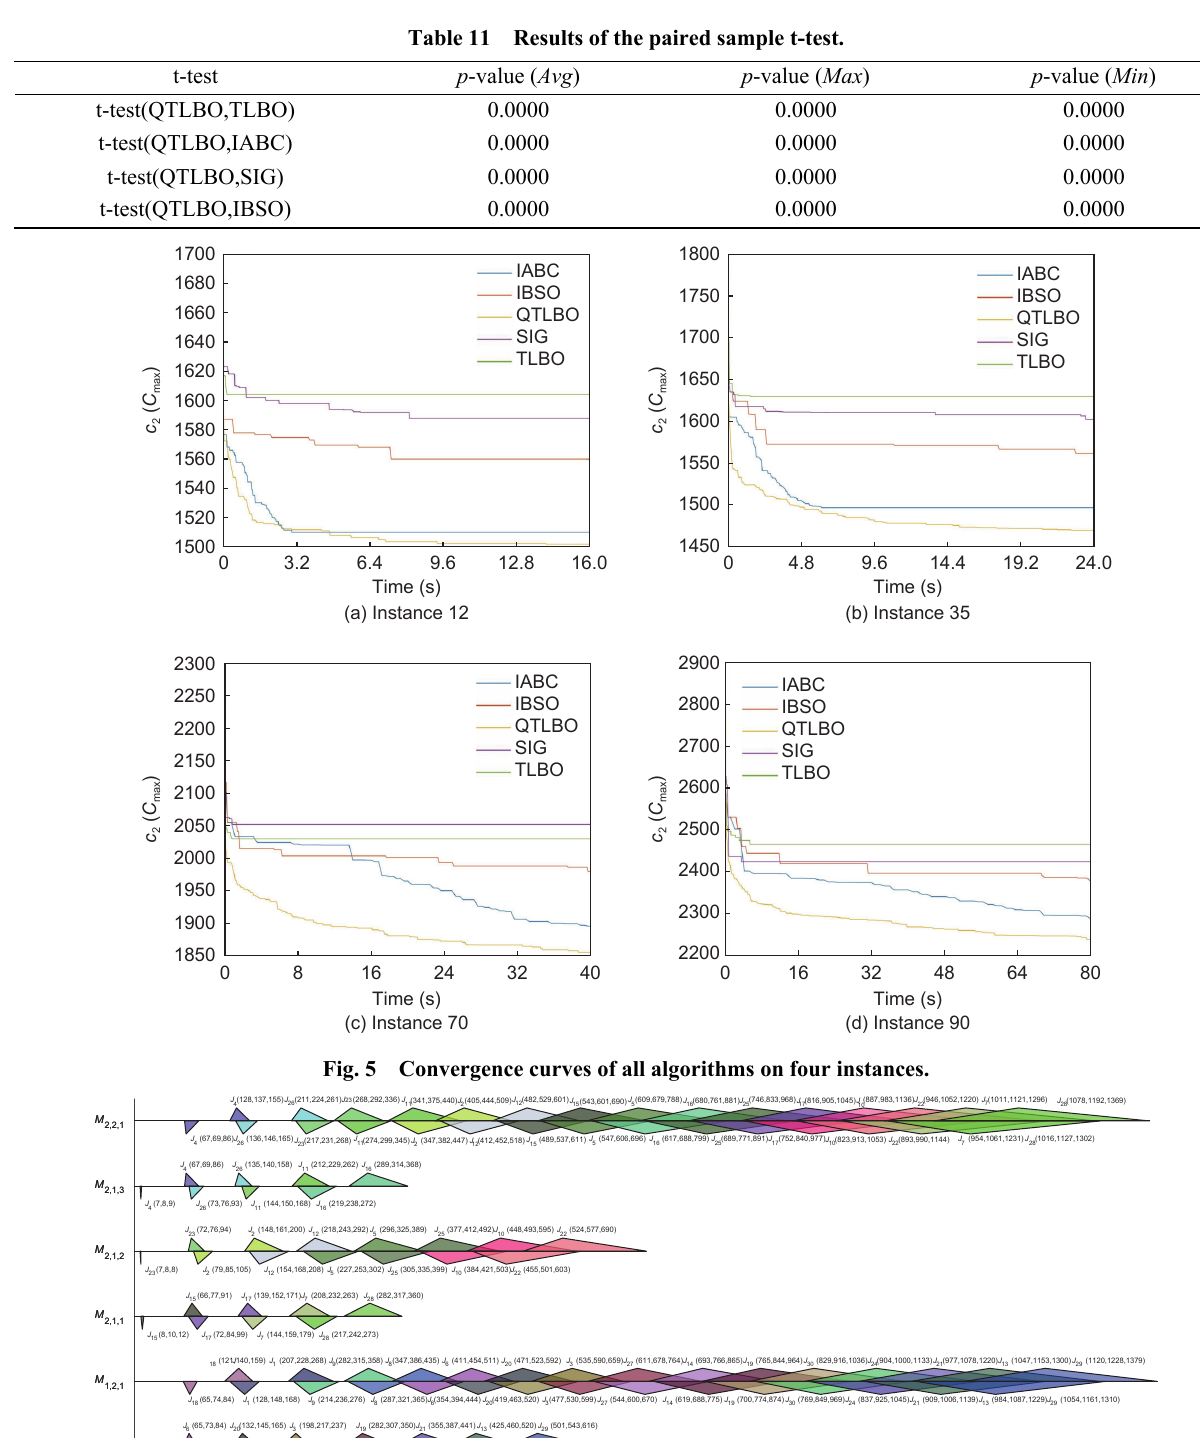
Table 11 Results of the paired sample t-test.